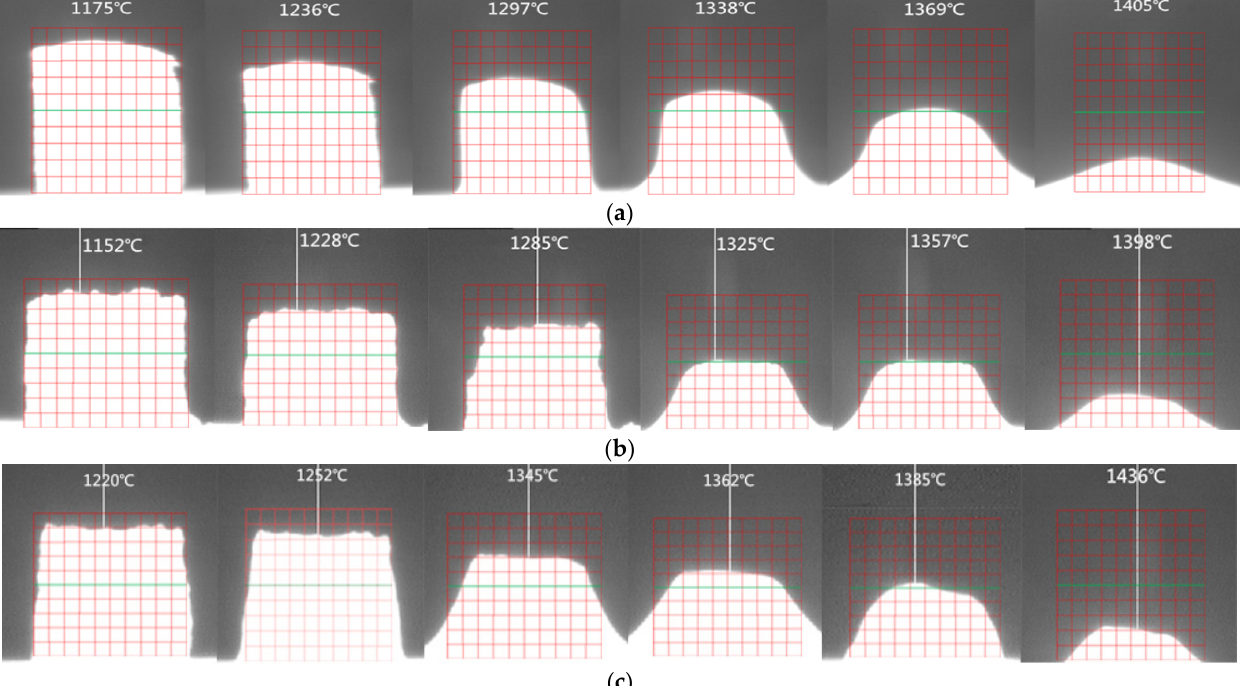
Figure 12. Melting process for samples with different Al 2 O 3 contents. ( a ) Al 2 O 3 content of 1.5%; ( b ) Al 2 O 3 content of 1.8%; ( c ) Al 2 O 3 content of 2.1%.